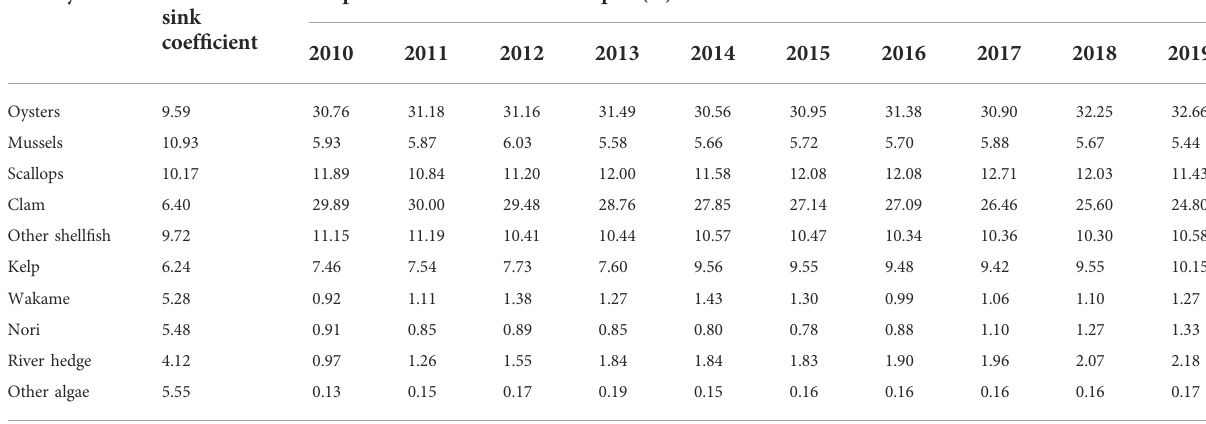
TABLE 4 Structure of shell fi sh and algae aquaculture from 2011 to 2019. Variety